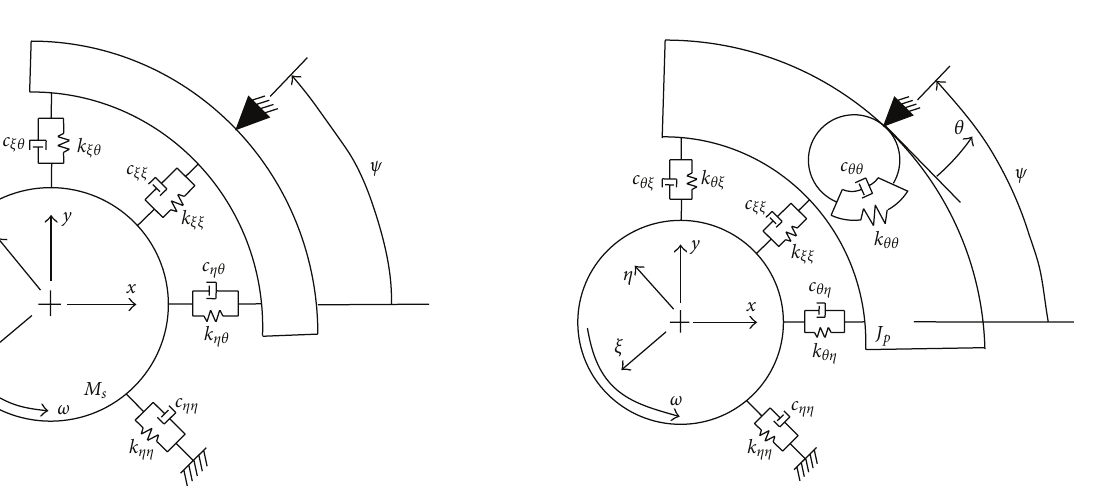
Figure 5: Free body diagram, pad rotational degrees of freedom, and rigid